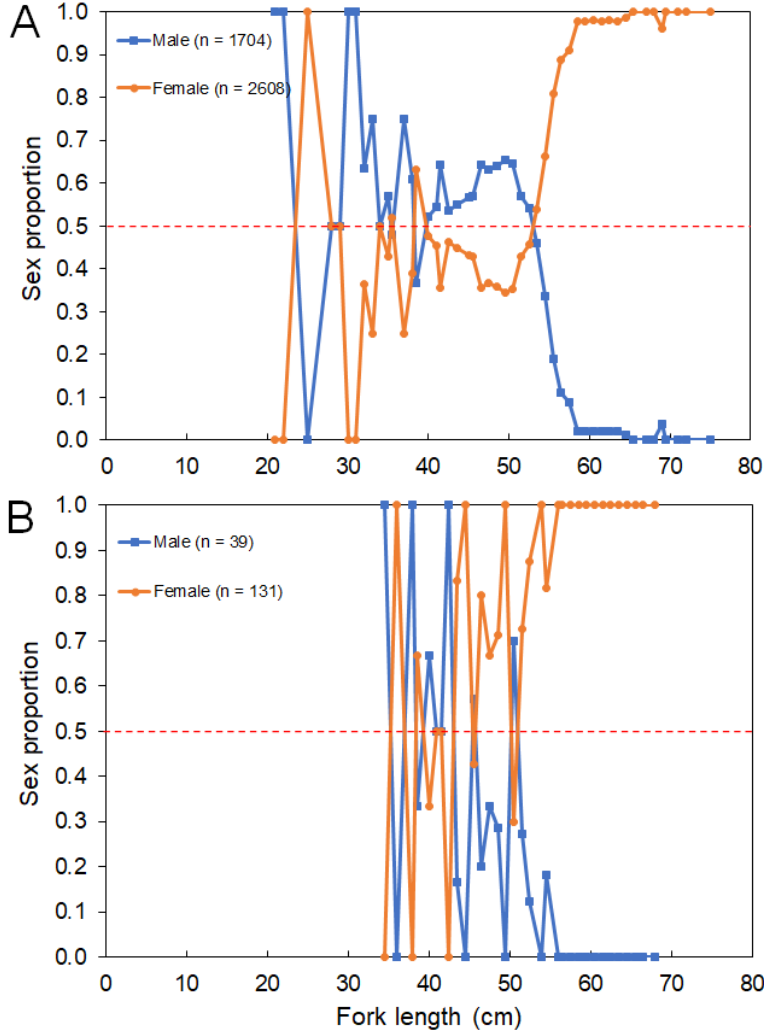
Figure 7. Sex proportion of Mora moro by fork length ( L F )–class derived from the ( A ) surveys (1996– 2019) and ( B ) commercial catches (2005–2017) in the Azores. Total number of individuals (n) refers to the total number of sampled M. moro . Red dashed line shows an equal sex ratio.